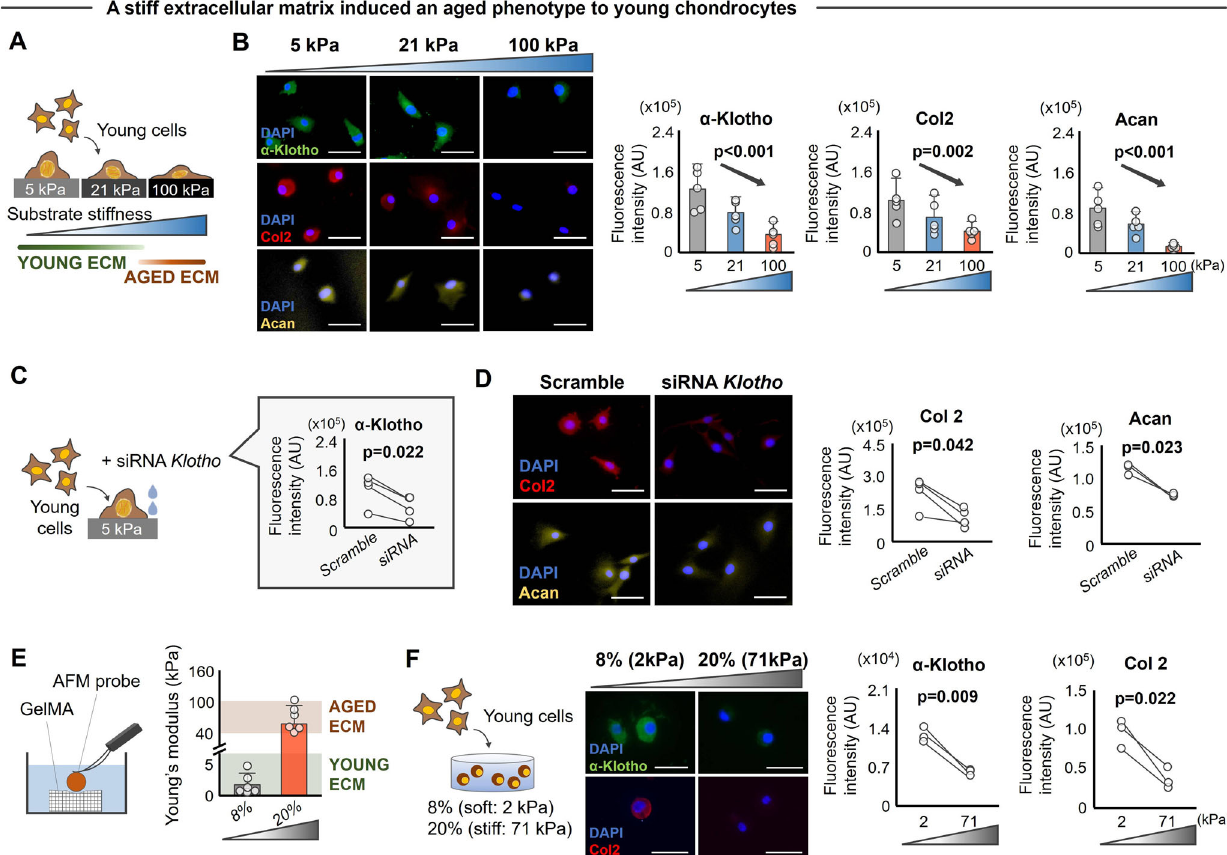
Fig.4|Matrixstiffnessregulateschondrocytehealthvia α -Klotho.A Schematic showing the experimental protocol. Primary chondrocytes isolated from young murine cartilage were seeded onto polyacrylamide gels engineered to mimic a physiologicalrangeofcartilagematrixstiffness(5kPa,21kPa,and100kPa). B .Stiff substratesreduced α -Klotho,typeIIcollagen(Col2),andaggrecan(Acan)inyoung chondrocytes, asquanti fi edbyimmuno fl uorescence( n =5/group; 30 – 70 cellsper individual sample). Scale bar: 50 μ m. C , D siRNA Klotho treatment inhibited the bene fi cial effect of soft substrates on type II collagen and aggrecan expression, as quanti fi ed by immuno fl uorescence ( n =3/group; 20 – 40 cells per